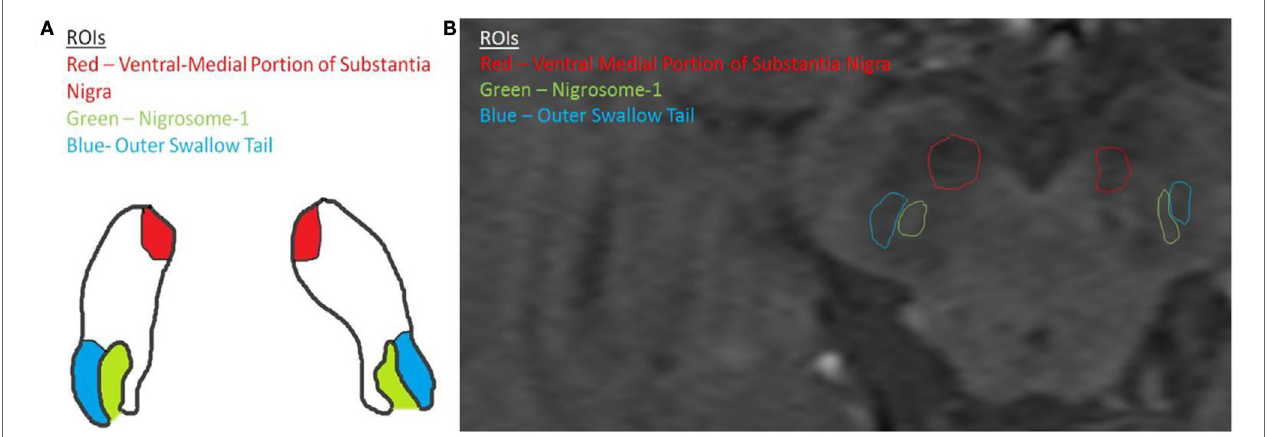
FigUre 2 | (a) Schematic diagram of ROIs and (B) ROIs as seen on patient MRI